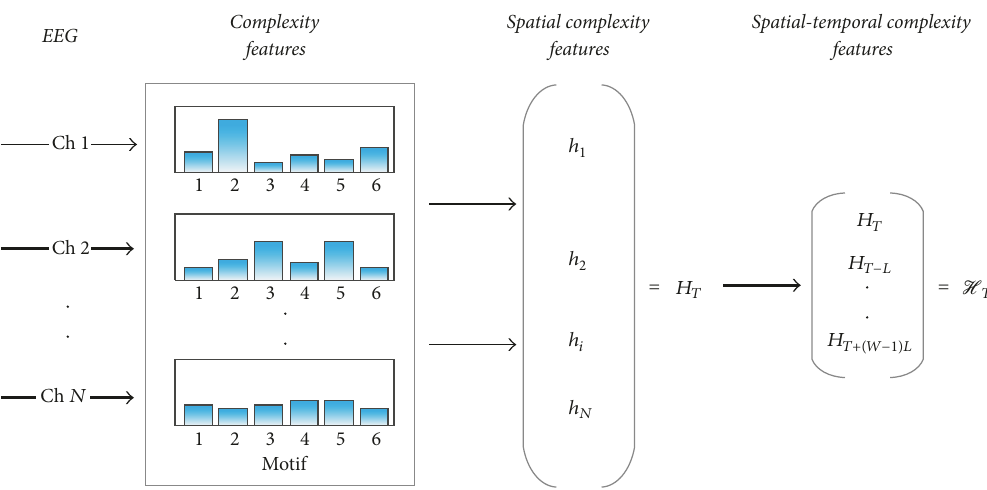
Figure 5: The extraction process of spatial-temporal permutation